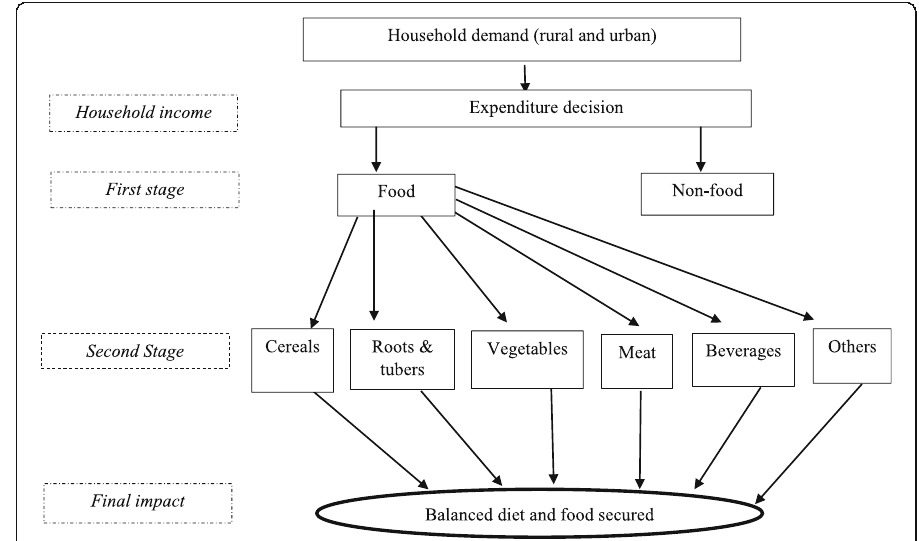
Fig. 1 Household two-stage budgeting approach for food demand in